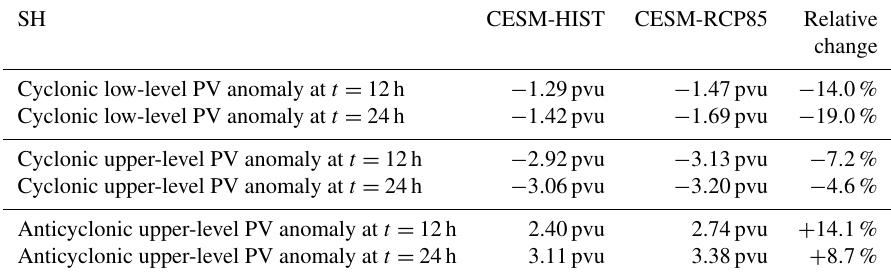
Table 4. Same as Table 3 but for SH winter.